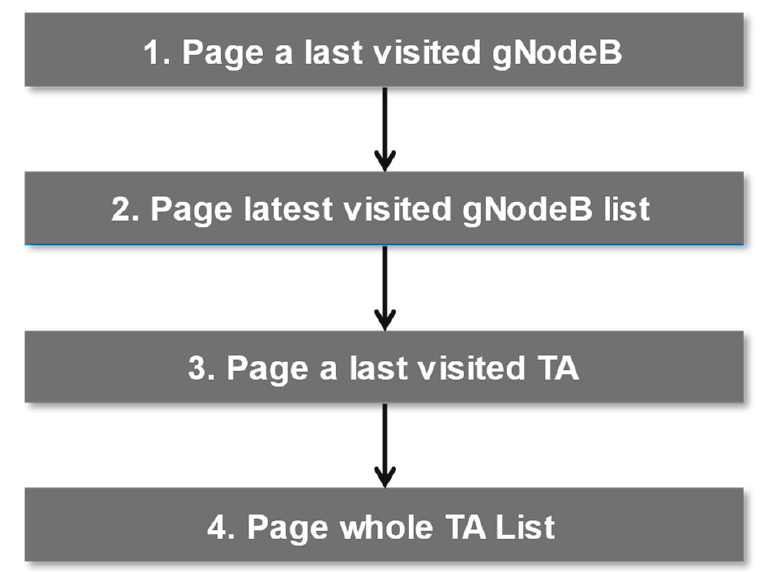
Figure 3. Typical AMF paging range profile.